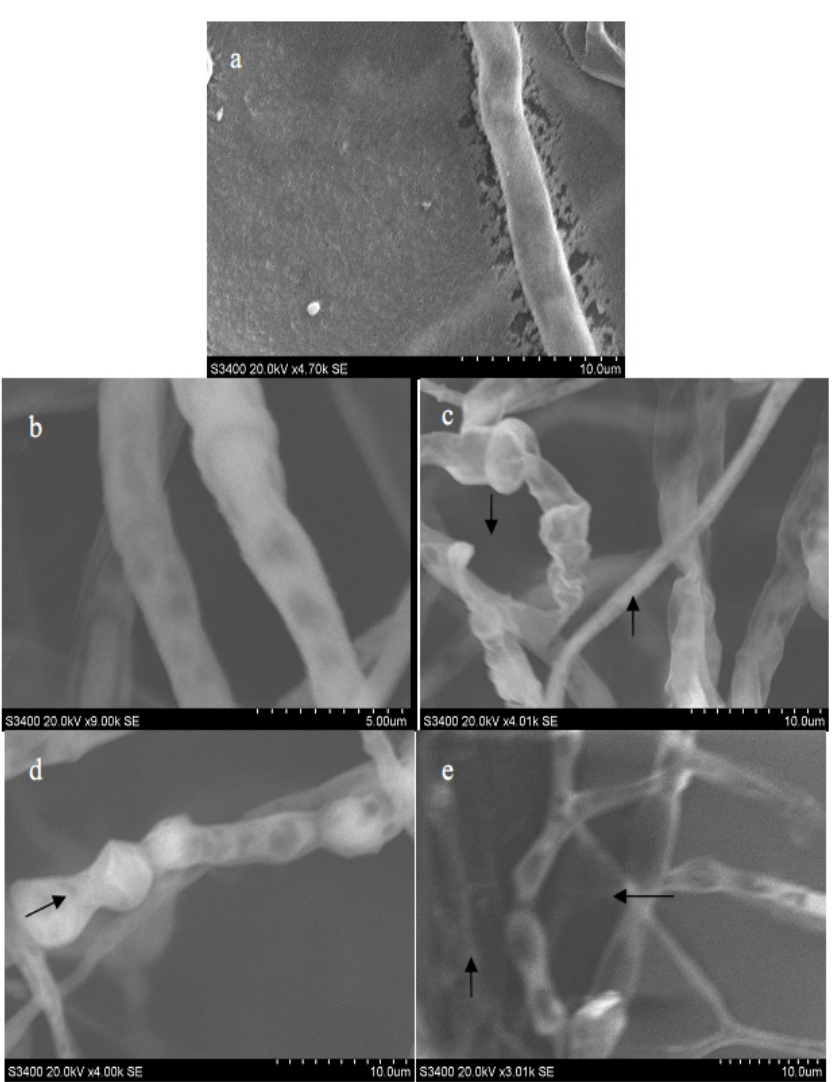
Figure 2. Scanning electron micrographs of M. grisea : Hyphae exposed to citral at concentrations of ( a ) 0 μ g/mL, ( b ) 50.00 μ g/mL, ( c ) 100.00 μ g/mL, ( d ) 150.00 μ g/mL, and ( e ) 200.00 μ g/mL. Arrows and arrowheads indicate hyphae shrinkage and partial distortion,